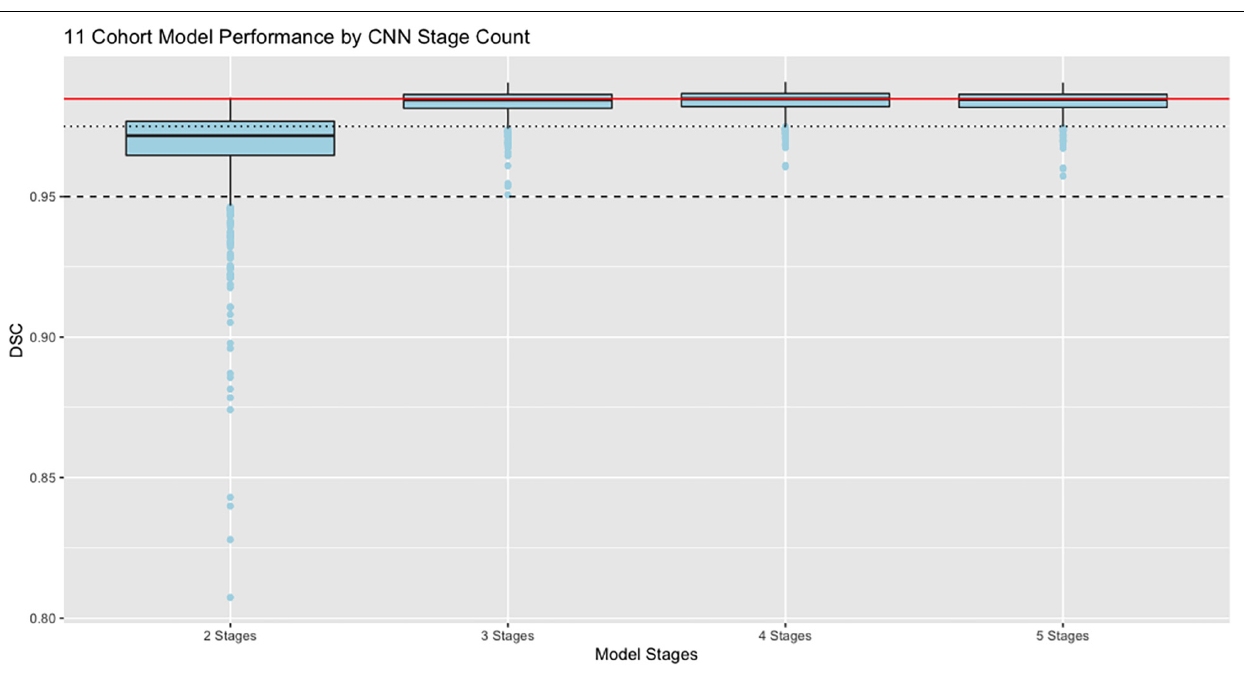
FIGURE 5 | Performance vs. number of stages. Dice similarity performance against test set ground truth ( N = 939) based on number of stages in the CNN, using the full 11 cohort training set. Red line is the median value 0.9848 achieved by the 4-stage architecture to allow easy comparison with the other models. Dashed line indicates DSC = 0.95; dotted line is DSC = 0.975. Boxes show lowest 25%, median, and 75%